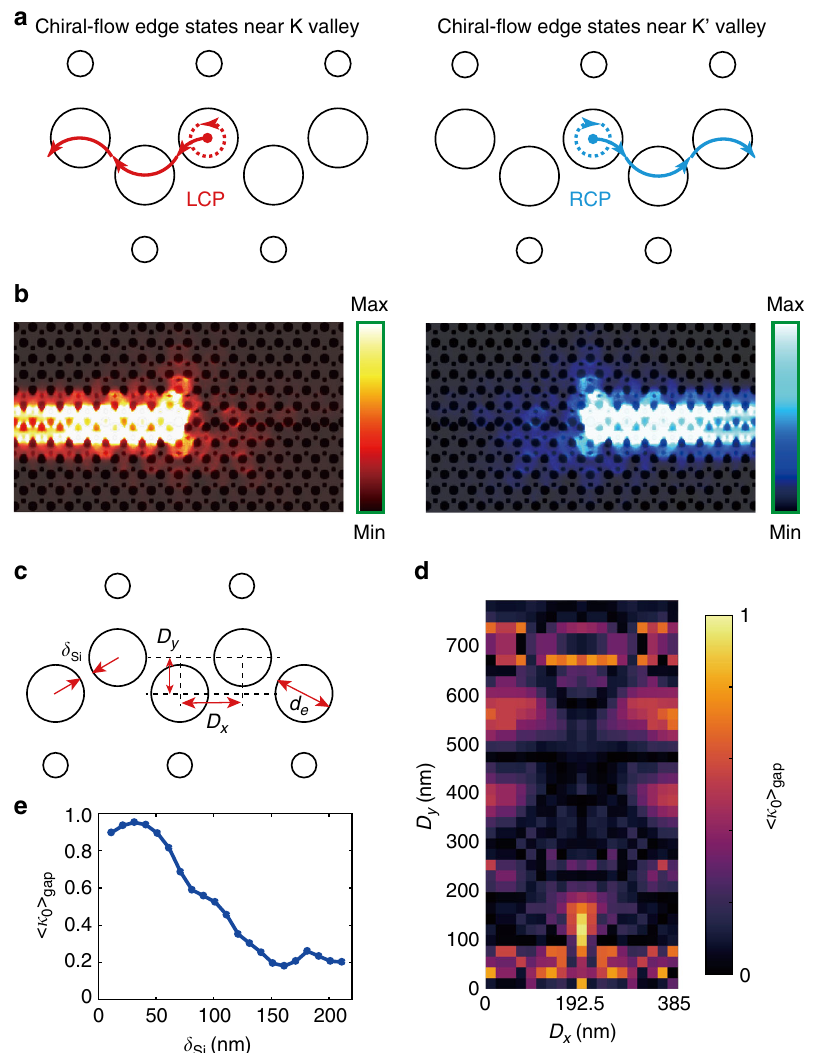
Fig. 3 Unidirectional coupling of valley-dependent edge states by using a circularly polarized chiral source. a Illustration of unidirectional coupling along the valley photonic crystal (VPC) interface, based on the selective excitation of the phase vortex. The vortex fi elds around the bearded holes at the upper domain will interact with those of the lower domain, and thus a chiral- fl ow edge state occurs. b Simulation of unidirectional coupling in a bearded-stack interface by controlling the chirality of a circularly polarized source at λ = 1430 nm. To simplify, a right-circularly polarized (RCP) or left-circularly polarized (LCP) dipole source is considered to generate a clockwise/anticlockwise phase vortex. c – e Analysis of unidirectional coupling ef fi ciency determined by an averaged parameter κ 0 h i . Here, κ 0 h i is related to the frequency-domain integration of directionality κ 0 in the whole bandgap. c Key geometry gap gap parameters for global directionality, including relative location ( D x and D y ) and diameter ( d e ) of bearded edge holes. The separation ( δ Si ) of the silicon ffiffiffiffiffiffiffiffiffiffiffiffiffiffiffiffiffi q ¼ þ D 2 κ (cid:3) d h i D 2 varied with relative locations D x and D y . The region between the two bearded holes is variable as δ e . d Simulated phase map of 0 x y gap Si maximum value emerges at the point of D x = 192.5 nm and D y = 111 nm, which is in correspondence with the valley-dependent topological interface. as a function of separation δ Si when tuning the diameters d e . Here, the relative position is fi xed with the maximum point e Global directionality κ 0 h i gap of Fig.